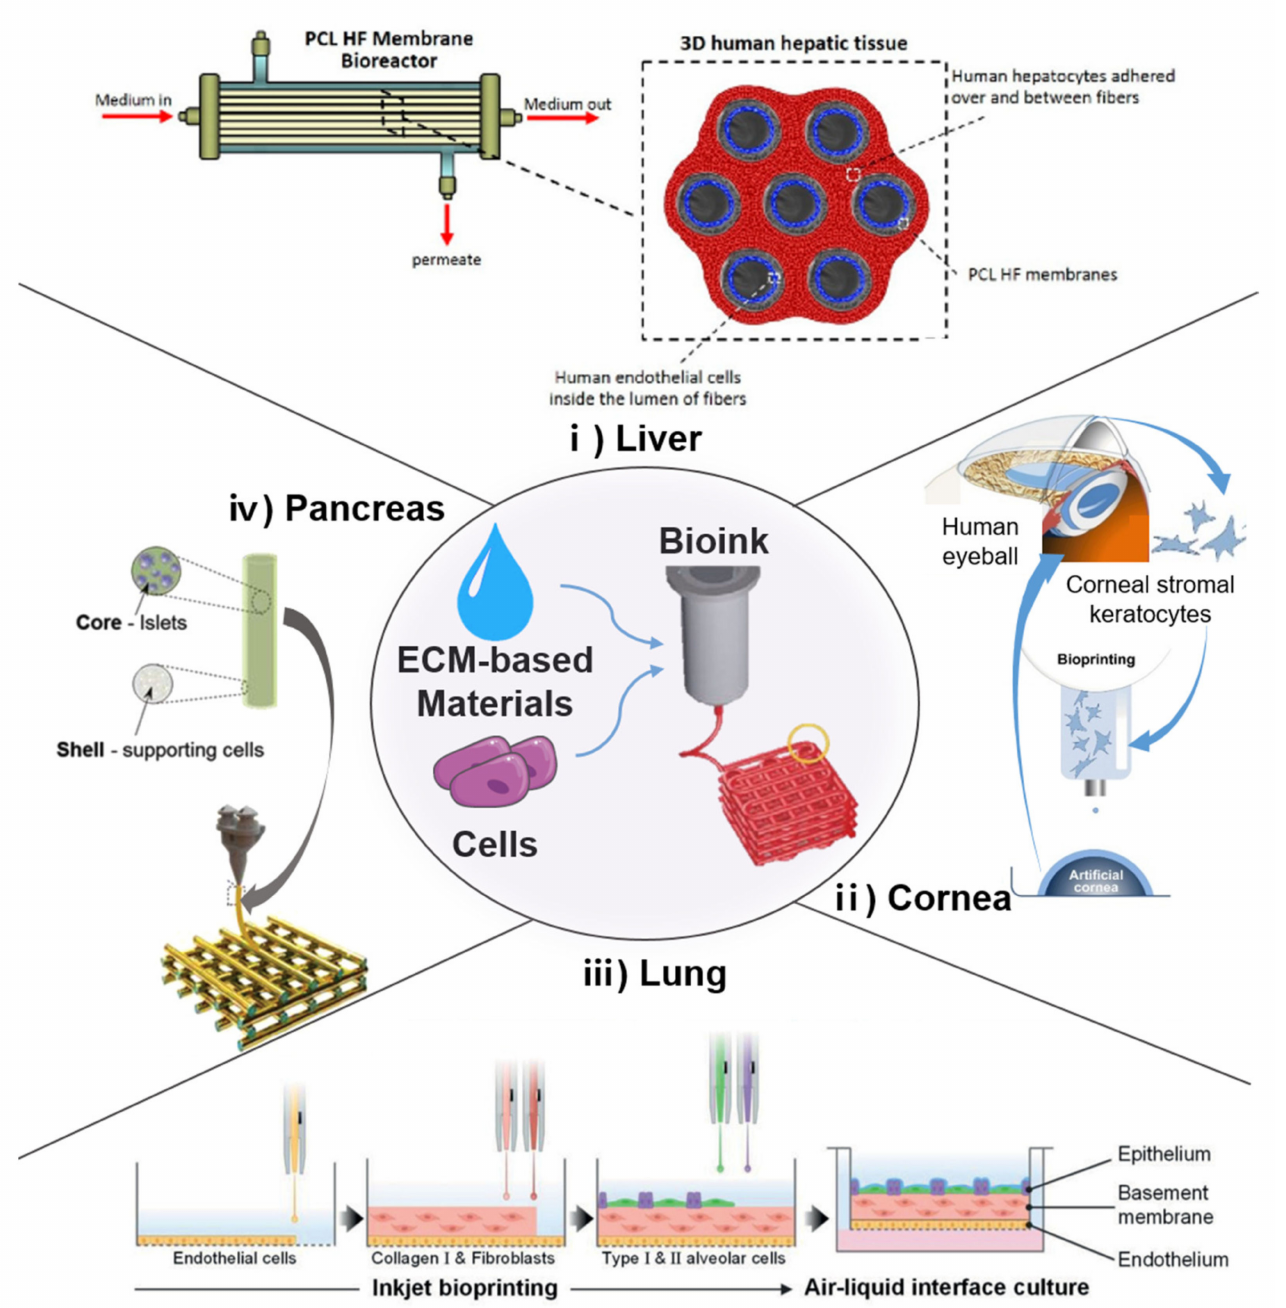
Figure 2. Applications of tissue engineering based on 3D bioprinting. ( i ) Poly( ε -caprolactone) (PCL) hollow fiber membrane bioreactor and scheme of 3D human hepatic tissue realized by culturing human hepatocytes over and between PCL HF membranes [129]. ( ii ) Bioprinting of functional and biomimetic 3D corneal model using hydrogels and cultivated human corneal stromal keratocytes [168]. ( iii ) Fabrication of alveolar barrier model with all cells inkjet-printed in a layer-by-layer manner [169]. ( iv ) coaxial printing approach for establishing vascularized bioartificial pancreatic constructs with pancreatic insulin-secreting cells housed in core component [170].